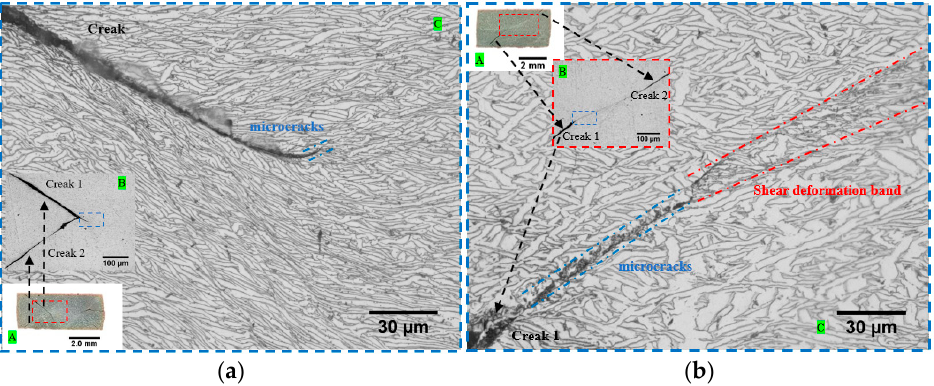
Figure 15. Microstructure of the specimen in longitudinal section under quasi-static conditions. ( a ) W-Z-0.001 s − 1 . ( b ) W-X-0.001 s − 1 . Region A is the cross-sectional photograph of the specimen after deformation, region B is the local magnified microstructure within the red-framed area in region A, and region C is the local magnified microstructure within the blue-framed area in region B.